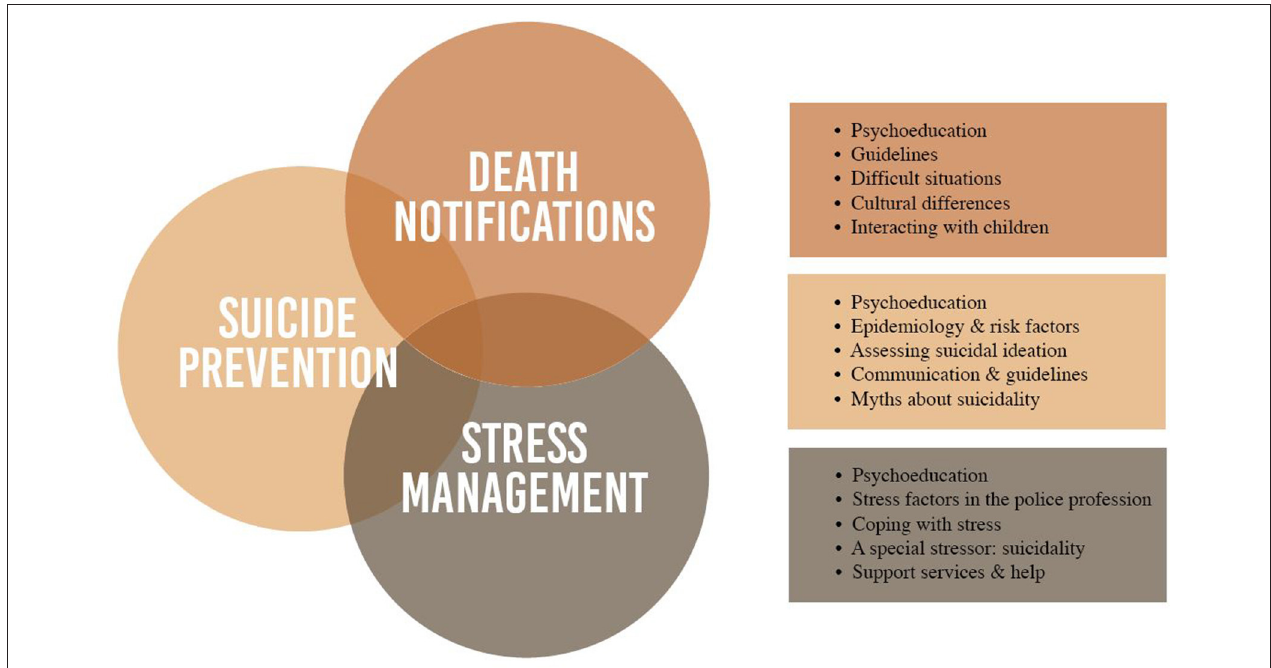
FIGURE 2 | Content of the